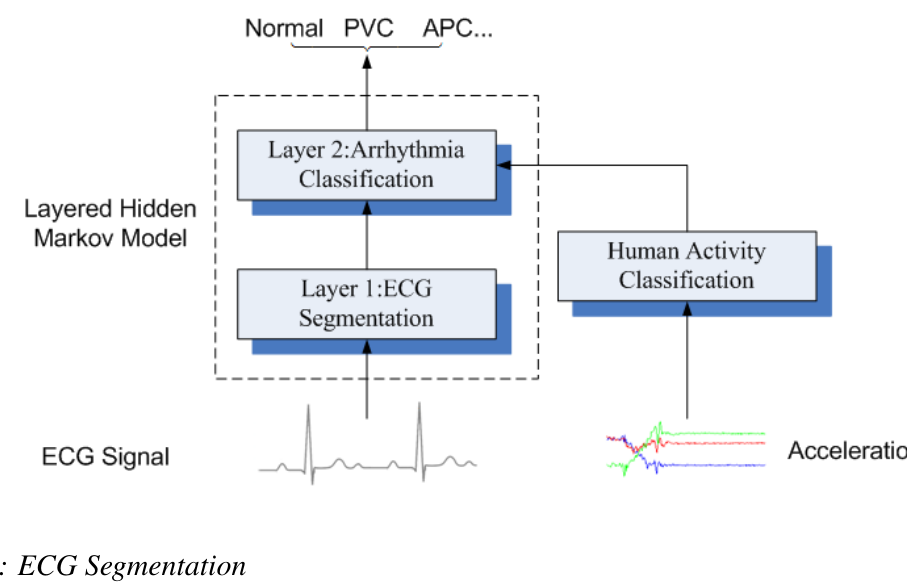
Figure 12. The block diagram of the proposed LHMM